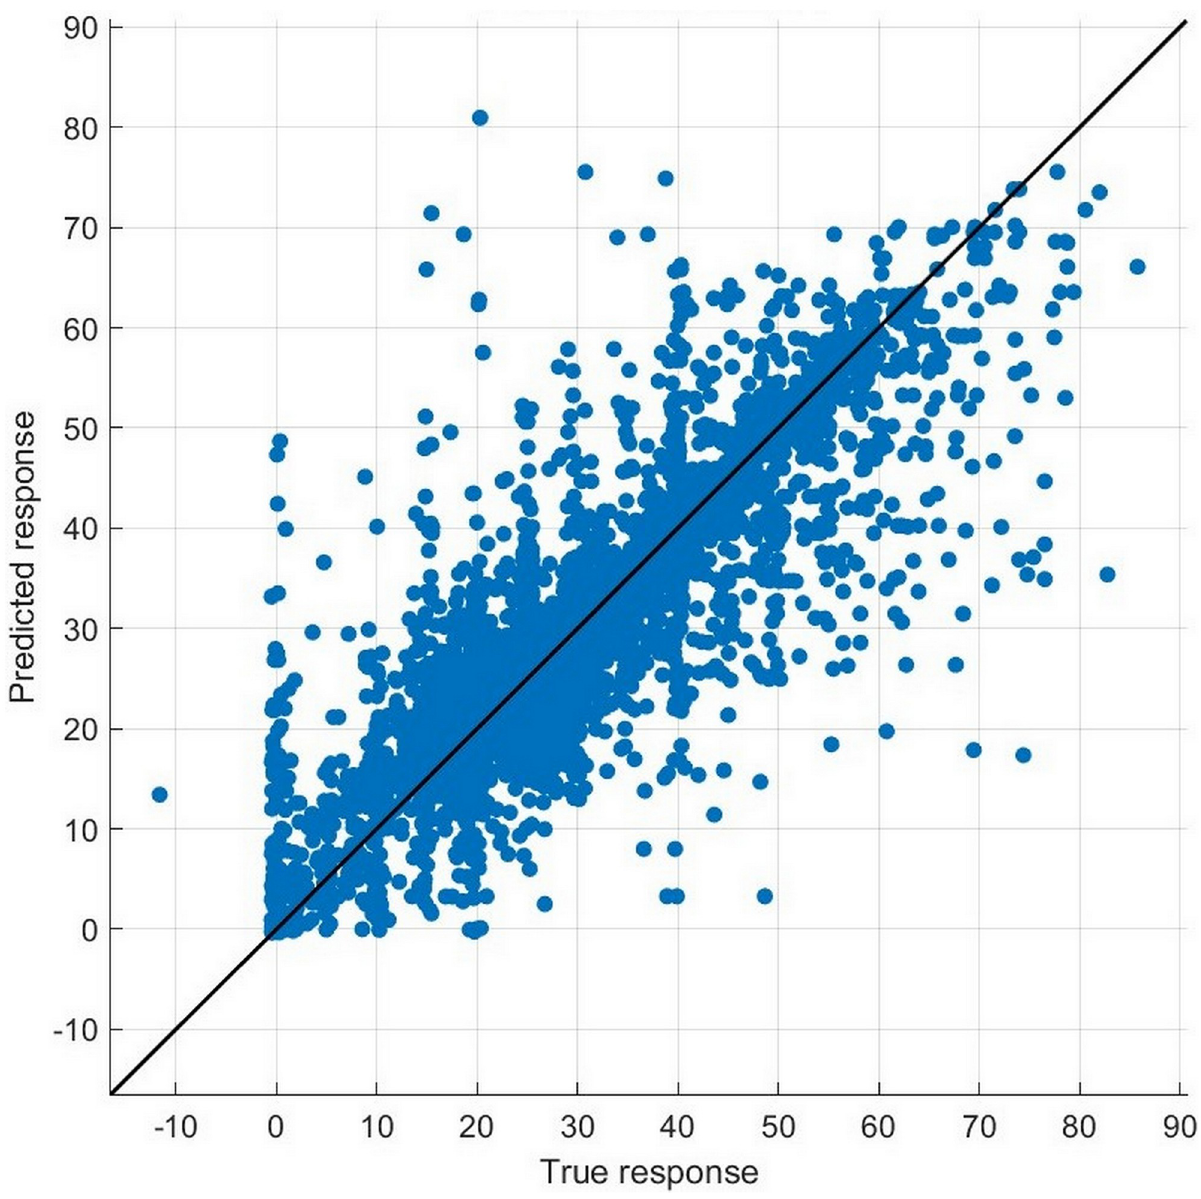
Fig 2. Predicted response versus true response of the trained optimizable tree